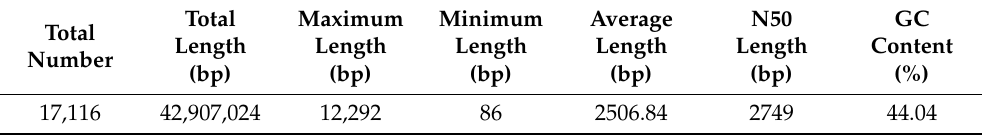
Figure 2. The length distribution map. ( a ) CCS length distribution. ( b ) Polished consensus isoforms length distribution. ( c ) The length distribution after redundancy removal. Table 2. Isoform statistics after redundancy removal.